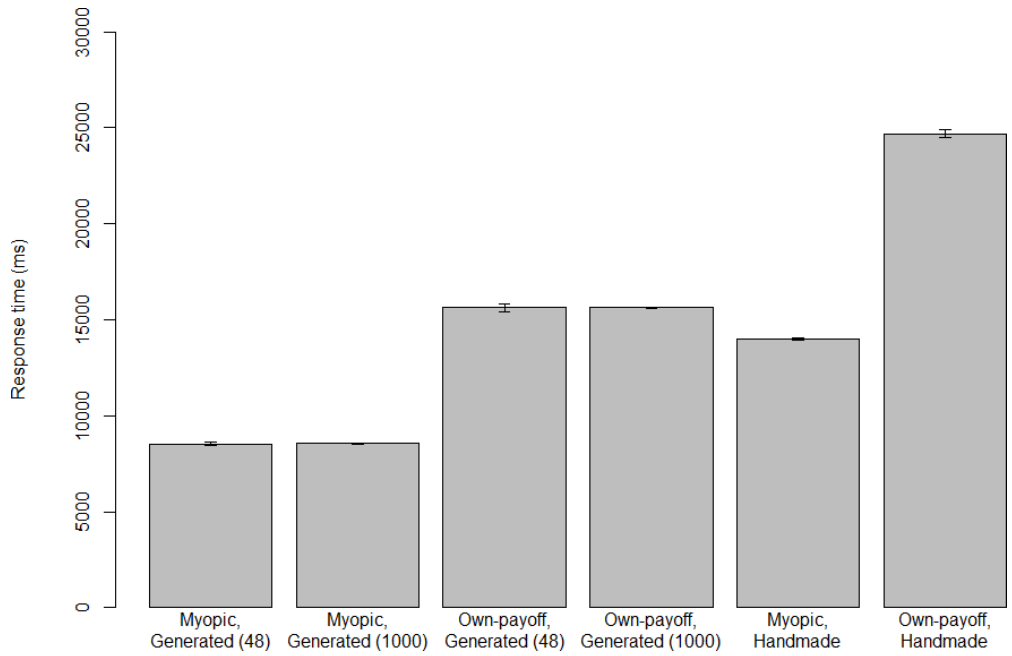
Figure 6. Reaction times in milliseconds for the automatically generated and handmade myopic and own-payoff cognitive models in Game 5. For generated models, the number between brackets indicates the number of virtual